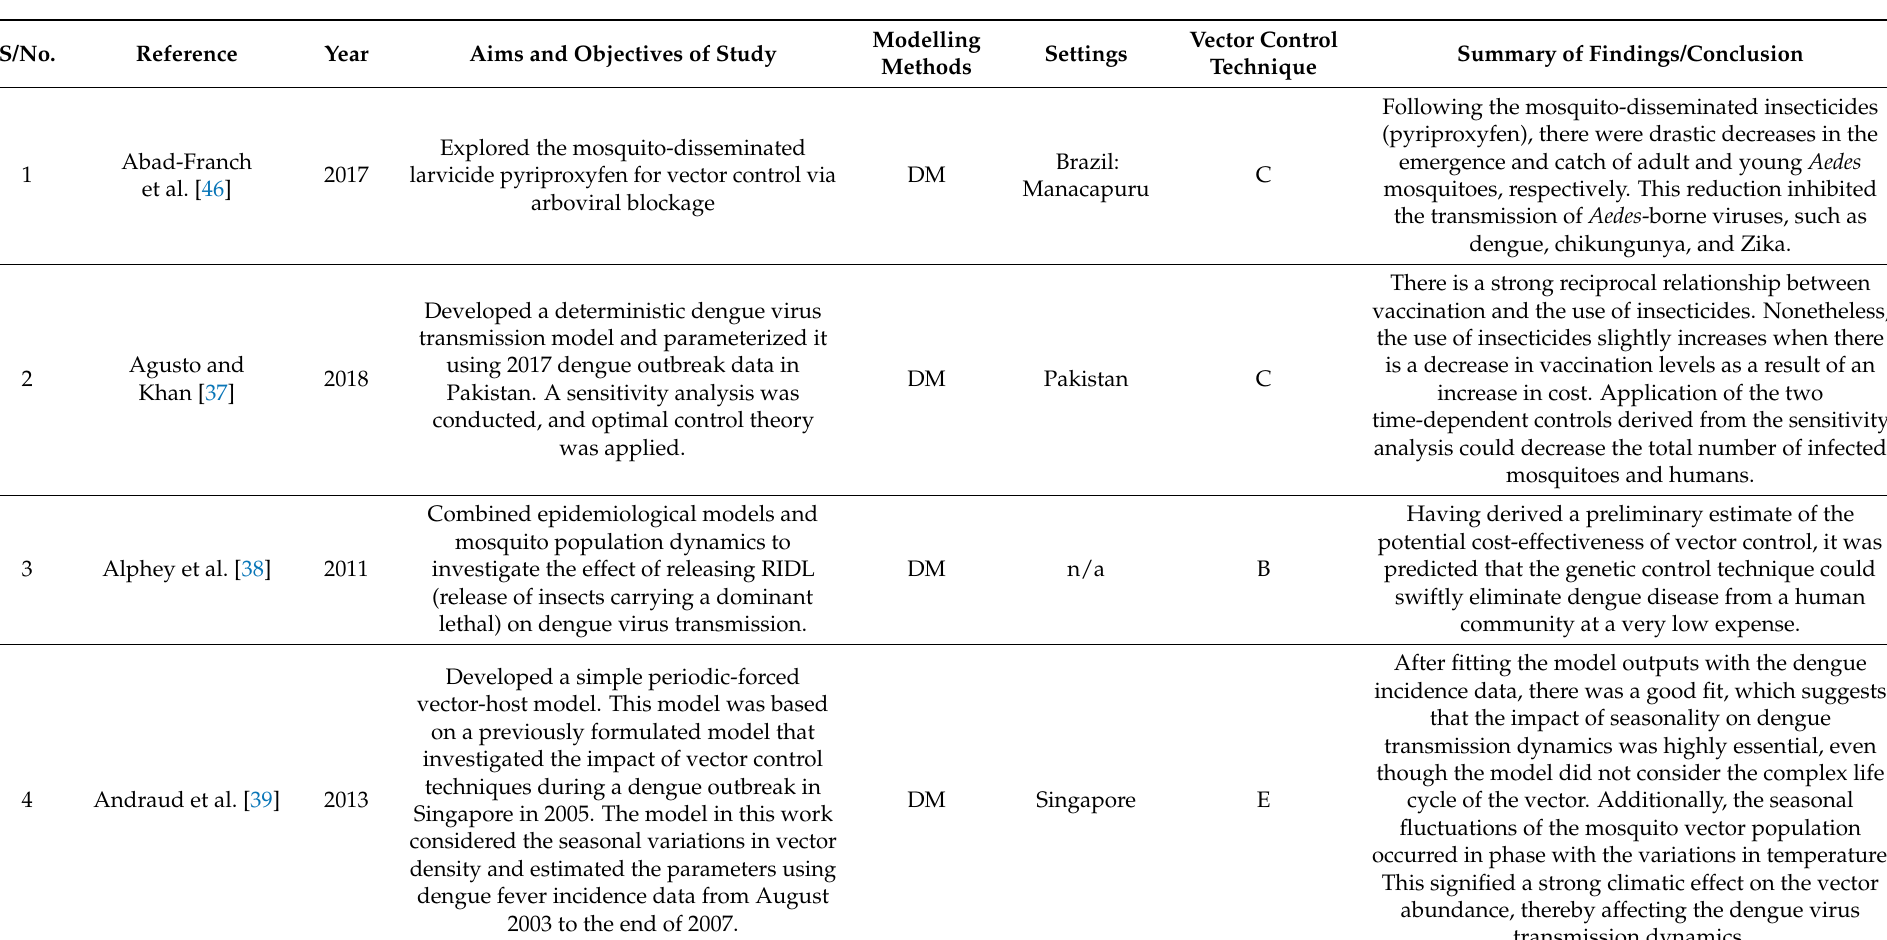
Table 1. Characteristics of selected articles describing the year, aims and objectives, modelling methods, settings location, main vector control method and summary of studies. DM → deterministic model, SM → stochastic model, and NM → network model. C → chemical control, B → biological control, and E → environmental control. n/a → not